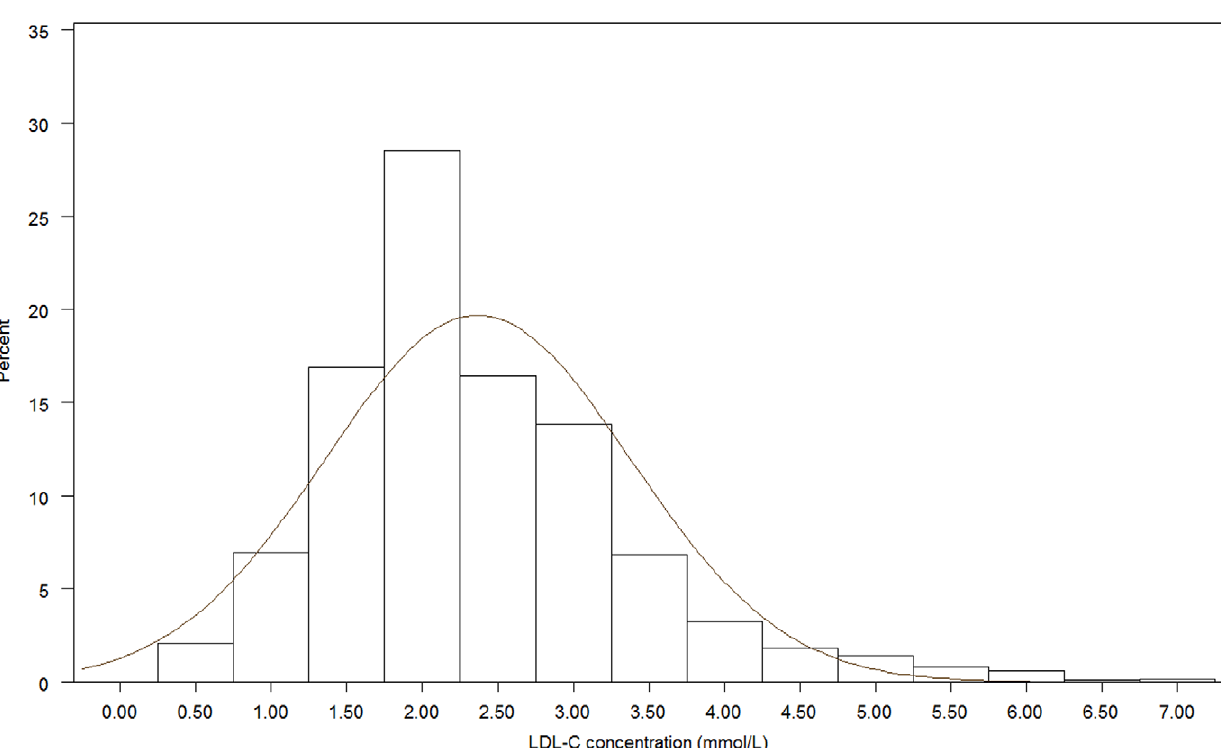
Figure 6. Histogram for the LDL-C values in patients on a statin and ezetimib combination.